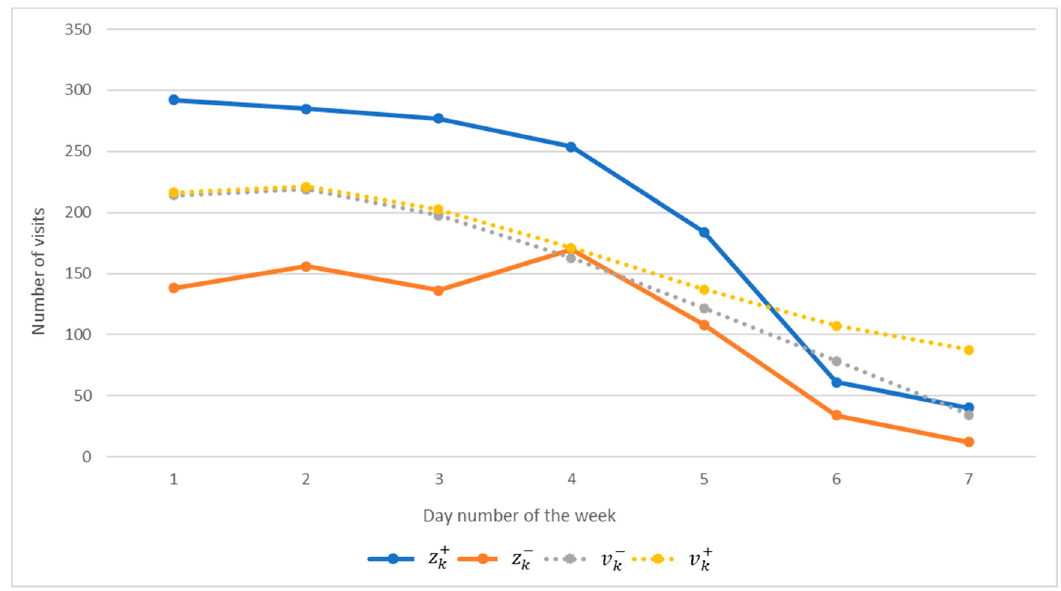
Figure 3. Predicted values of user activity on specified resource, obtained using an interval discrete model (IDM) (16).